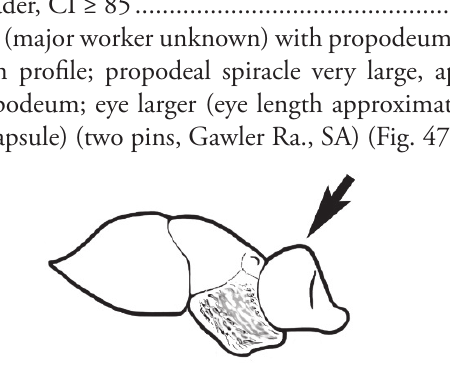
not conical in profile; propodeal spiracle shorter (≤ 0.60× height of propo- deum) ....................................................................................................... 51 51 Head and mesosoma of minor worker strongly matt, dull, with uniform, minute, net-like microreticulation; a transverse row of short, stout unmodi- fied setae placed across centre of pronotum; in profile, propodeum weakly rounded or forming a slight angle between dorsal and declivitous faces (major worker unknown: known only from Eneabba region and Yanchep NP, WA) ( JDM 1180 ) (Fig. 38a–d) ............................................................... latinotus